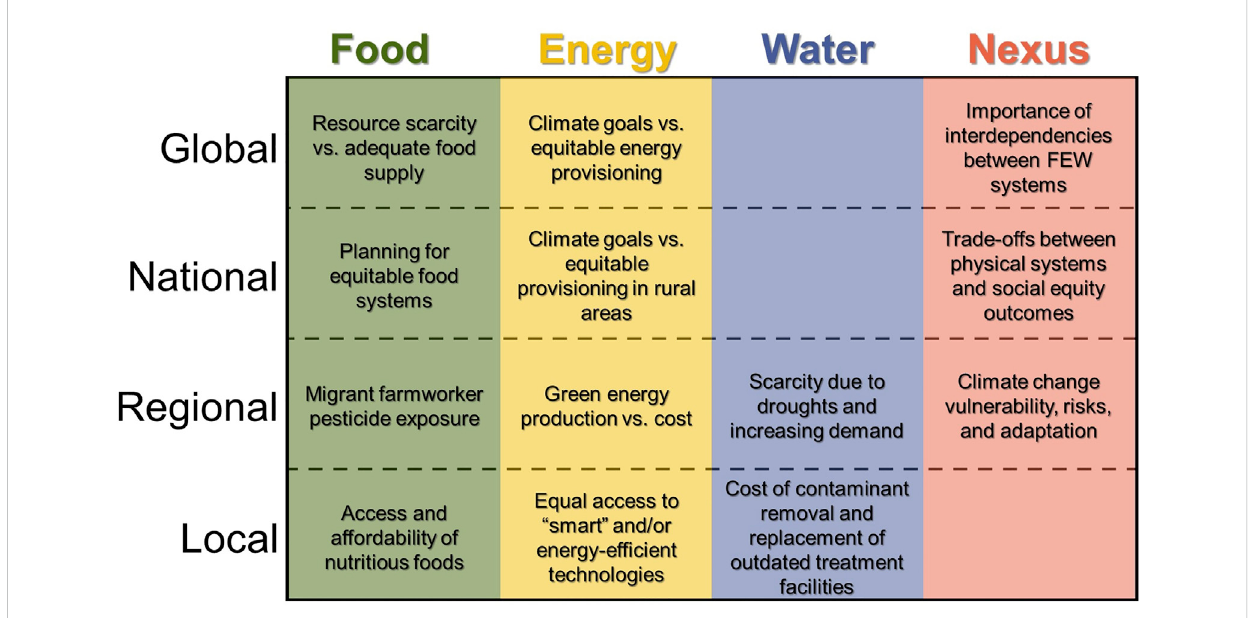
FIGURE 3 Major themes for food (green), energy (yellow), water (blue) and their nexus (red) identi fi ed for local, regional, national, and global